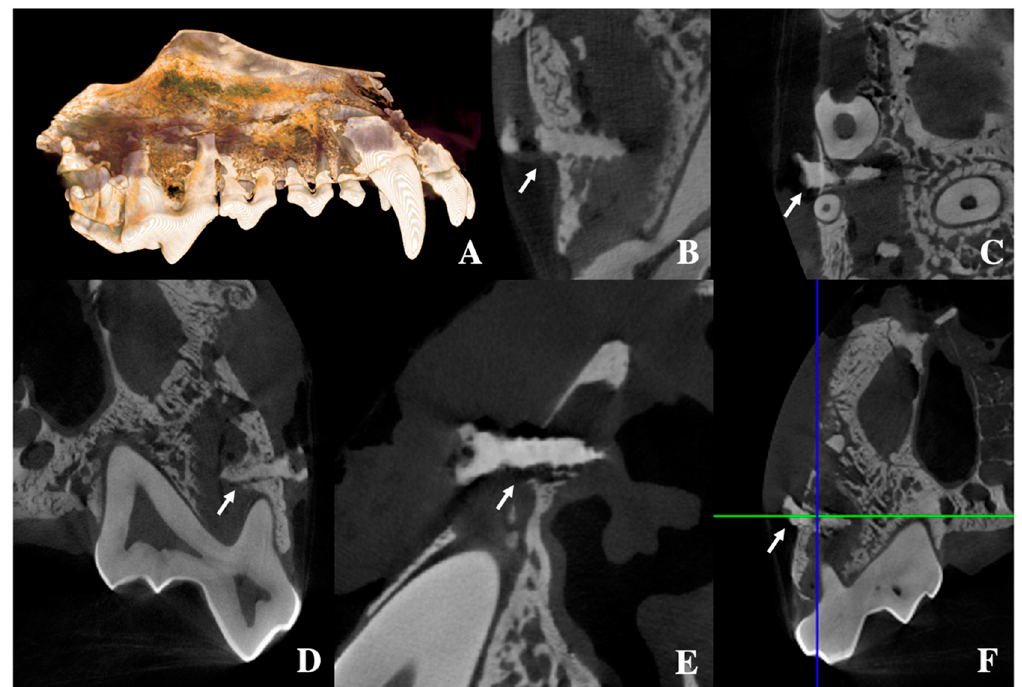
Figure 4. Radiological evaluation after 12 weeks. Only a few screw bodies fixed in the bone remained, and screw heads had mostly been absorbed after 12 weeks (arrow: remaining screw). ( A ) harvested maxilla; ( B ) separated screw head; ( C ) completely absorbed screw head; ( D , E , F ) partially absorbed screw heads.